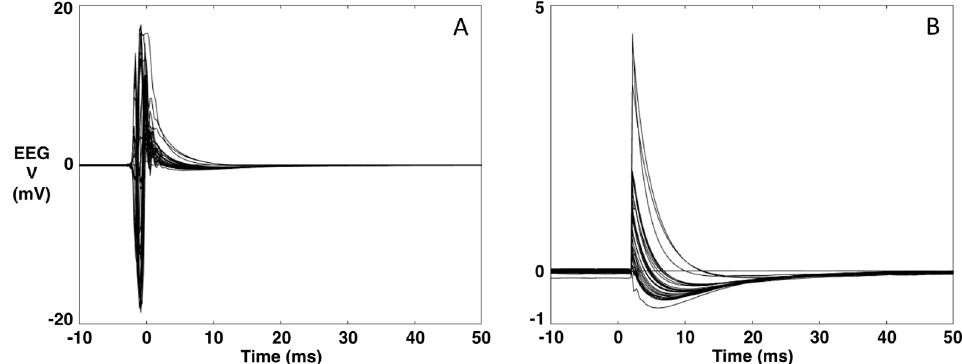
Figure 1. Example of an EEG recording during TMS. ( A ). Original data averaged over the TMS stimulus ( t = 0). ( B ). The data after replacing the [ − 3, 2] ms interval with the 5-ms interval of the baseline [ − 8, − 3] ms.